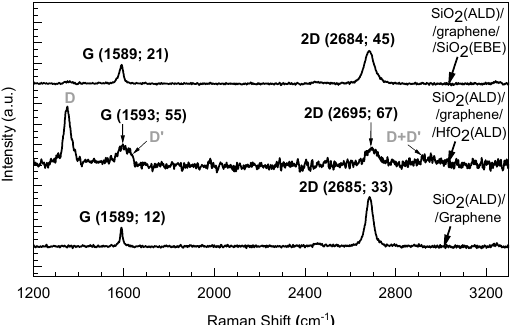
Figure 3. Typical Raman spectra of graphene-based stacked nanostructures. All spectra are normal- ized according to the G–band intensities. The positions and widths of the main bands (G and 2D) are indicated as labels in the spectra. The order of layers in stacked structures is also denoted by labels.